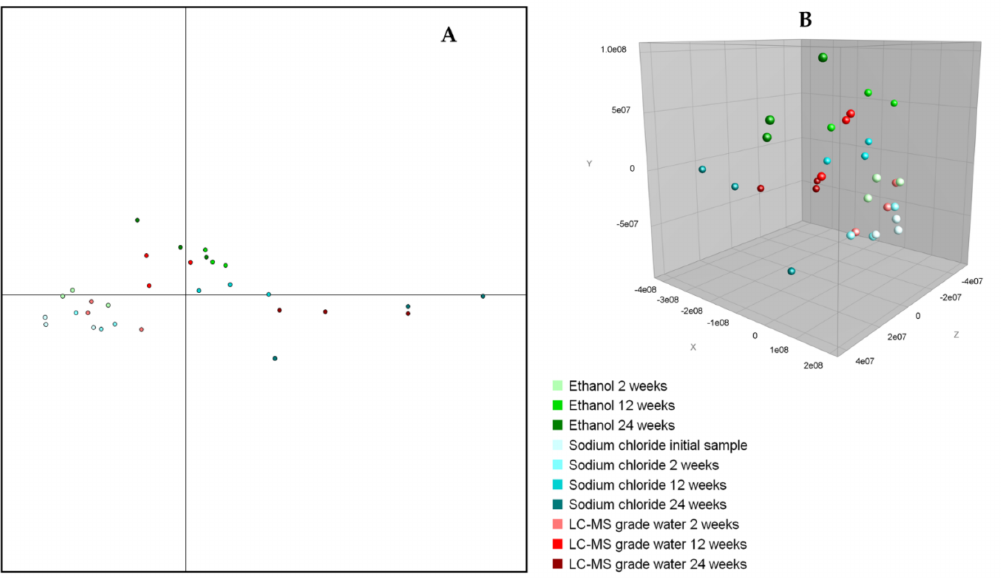
Figure 4. Discriminant analysis and principal components analysis (PCA) of Taenia saginata proglottids stored in different preservation media for different time periods. Each storage medium is depicted with a different color. Both statistical analyses indicate that the clusters are highly related and cannot be separated. ( A ) Two-dimensional view of the discriminant analysis. ( B ) Three-dimensional view of the